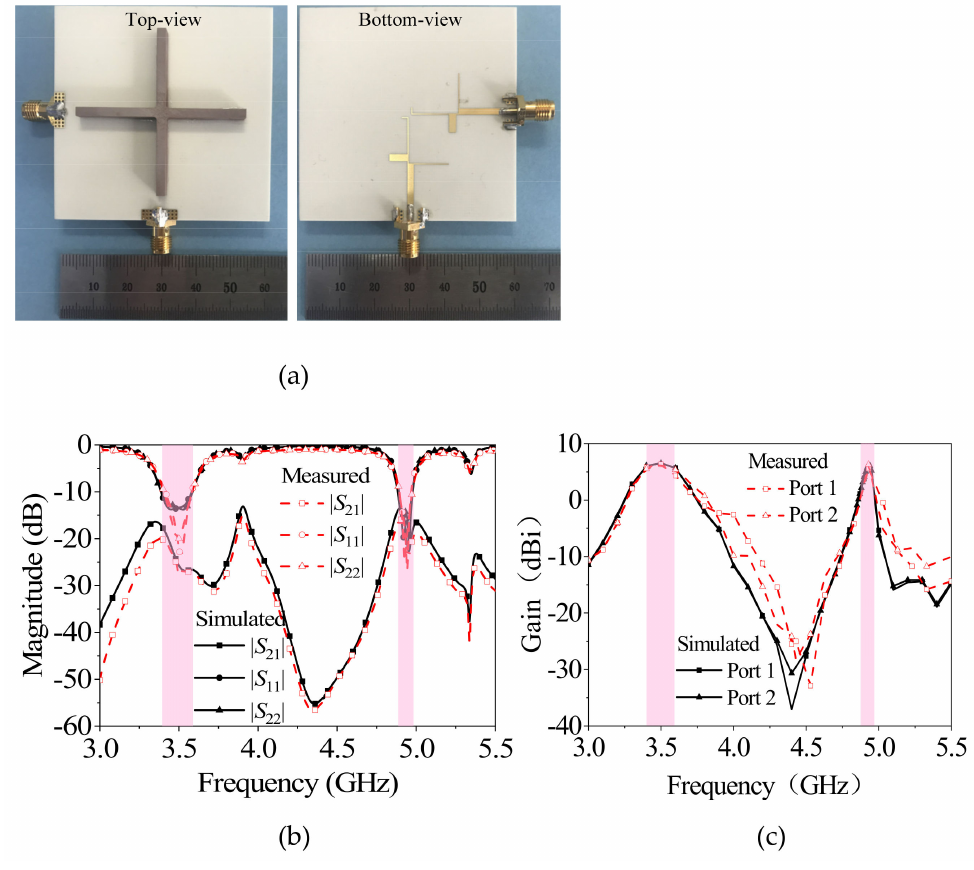
Figure 6. Photographed, simulated, and measured results of the proposed antenna: ( a ) photograph; ( b ) |S 21 |, |S 11 | and |S 22 |; ( c )